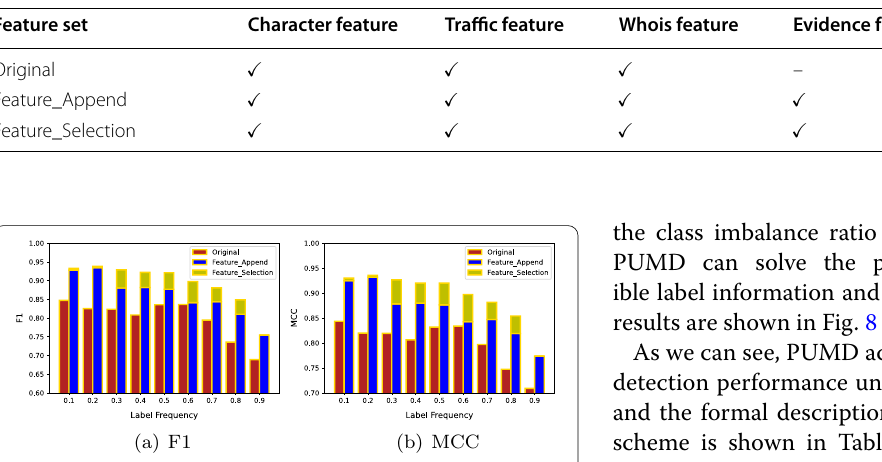
Table 9 Feature set summarize